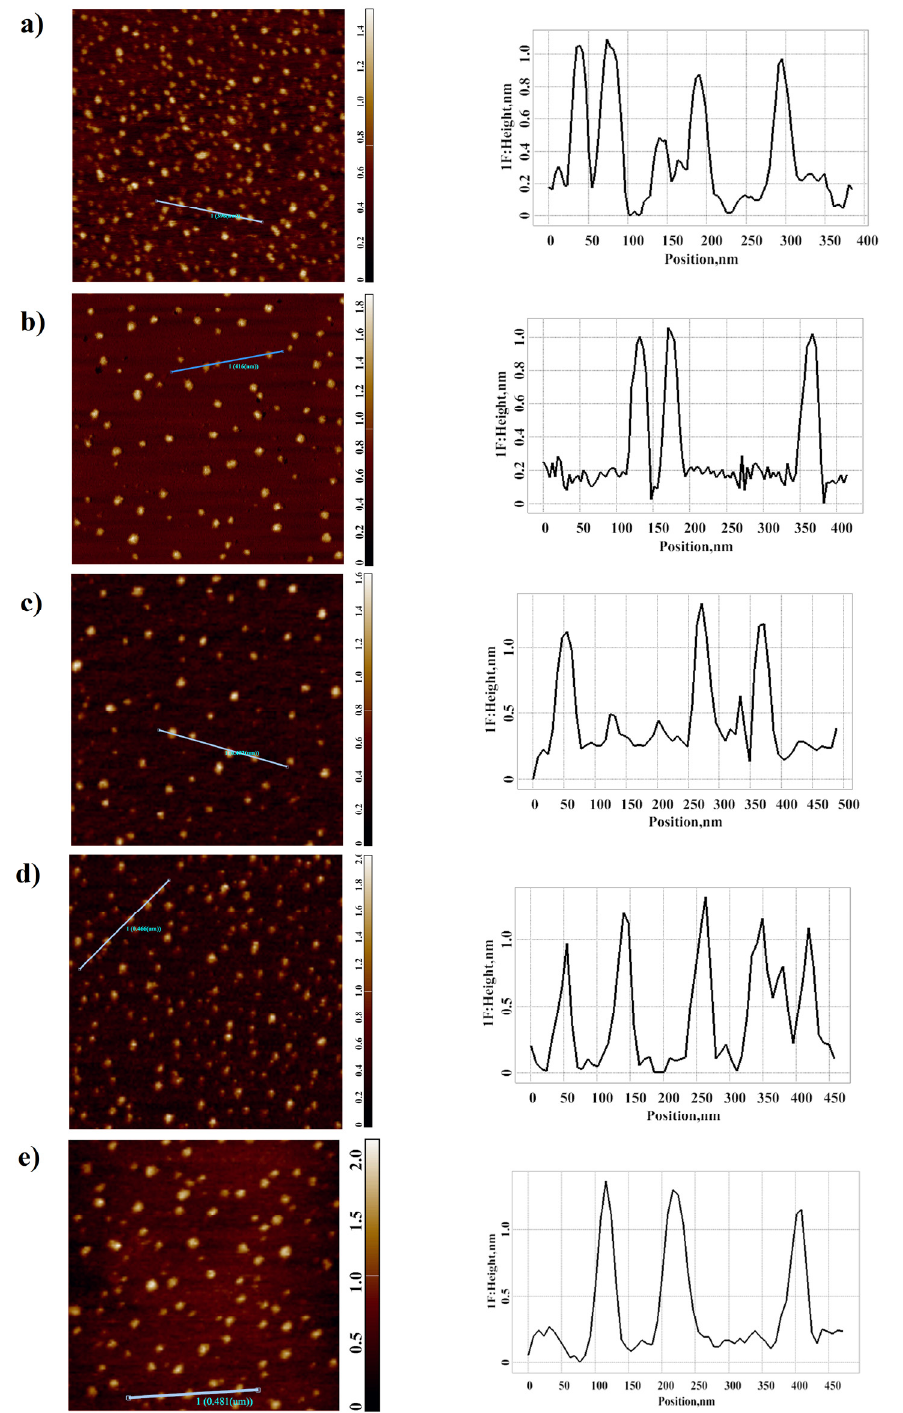
Figure 2. Results of AFM experiments. Typical AFM images of the surface of mica substrates with adsorbed HRP macromolecules (left) and cross-section profiles (right), corresponding to the lines in the AFM images. The analyzed HRP solution was incubated either 2 m away from the metallic half-sphere ( a ) (control solution) or within the half-sphere: in its center ( b ), near its edge ( c ), and at its bottom ( d ); or in the center of the grounded sphere ( e ). Scan size: 1 µ m × 1 µ m ( a – e ); Z scale: 1.6 µ m ( a , c ), 2.0 µ m ( b , d , e